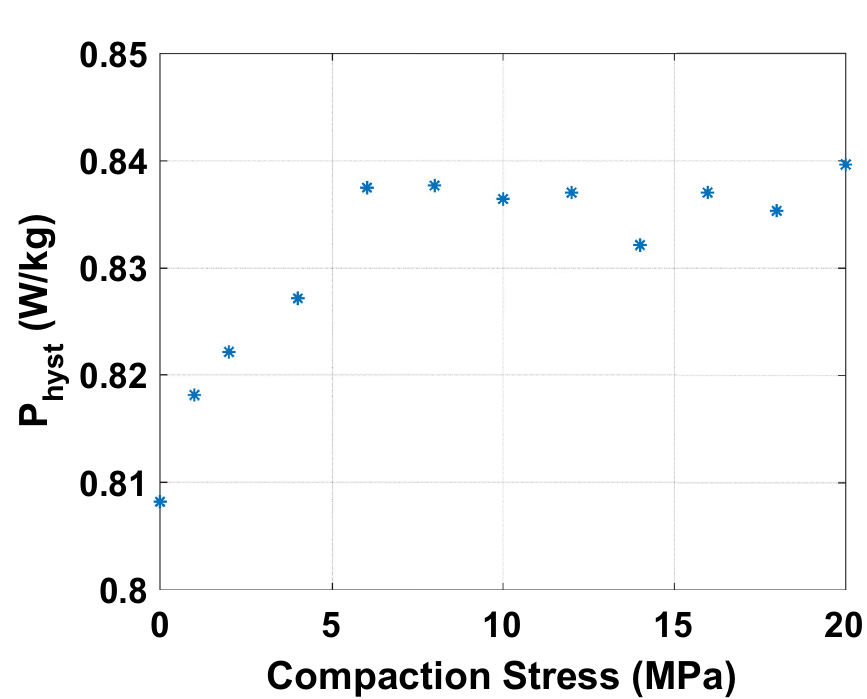
Figure 20. Hysteresis loss evolution as a function of compaction stress for 1 T at 50 Hz - Homogeneous